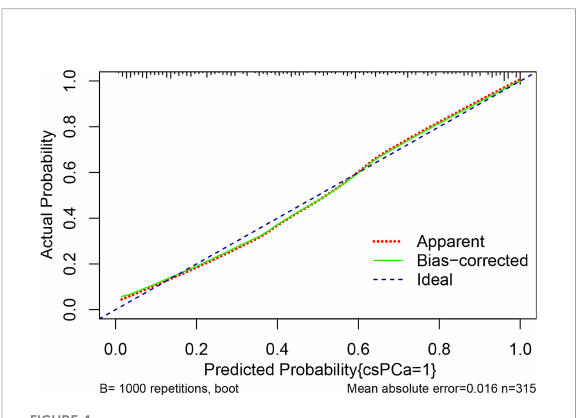
FIGURE 4 The calibration curve compares the accuracy of the original prediction model ( “ apparent ” ) (light dashed red line) to the bootstrap model ( “ bias corrected ” ) (solid green line) in predicting the likelihood of csPCa. The ideal calibration is shown by the diagonal blue dot line, which serves as the reference line. The abscissa indicates the anticipated value determined from the nomogram, whereas the ordinate re fl ects the observed actual probability value. Small vertical lines at the top of the graph represent the distribution of the expected probability. Overprediction occurs when an estimate falls below the reference line, while underprediction occurs when an estimate rises above the reference line. In an ideal situation, these two lines should be close to the diagonally dashed blue